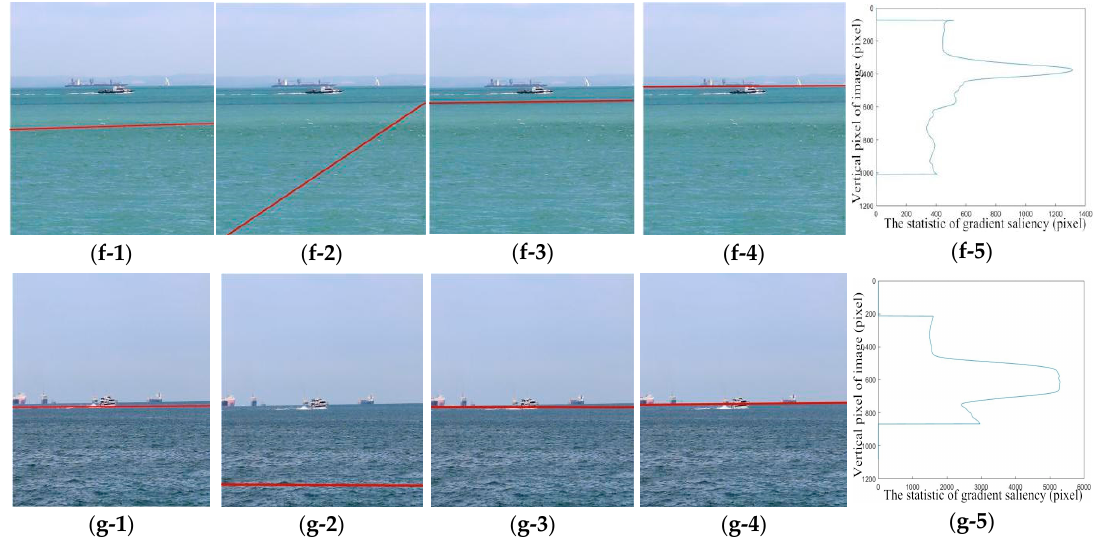
Figure 3. Detection results of di ff erent sea-sky-line detection methods for datasets. (Column 1) Show the images processed using the SSM. (Column 2) Show the images processed using the Hough transformation algorithm. (Column 3) Show the images processed using gradient saliency enhancement and Hough algorithm. (Column 4) Show the images processed using our algorithm. (Column 5) Show the images processed using integral curve of gradient saliency.